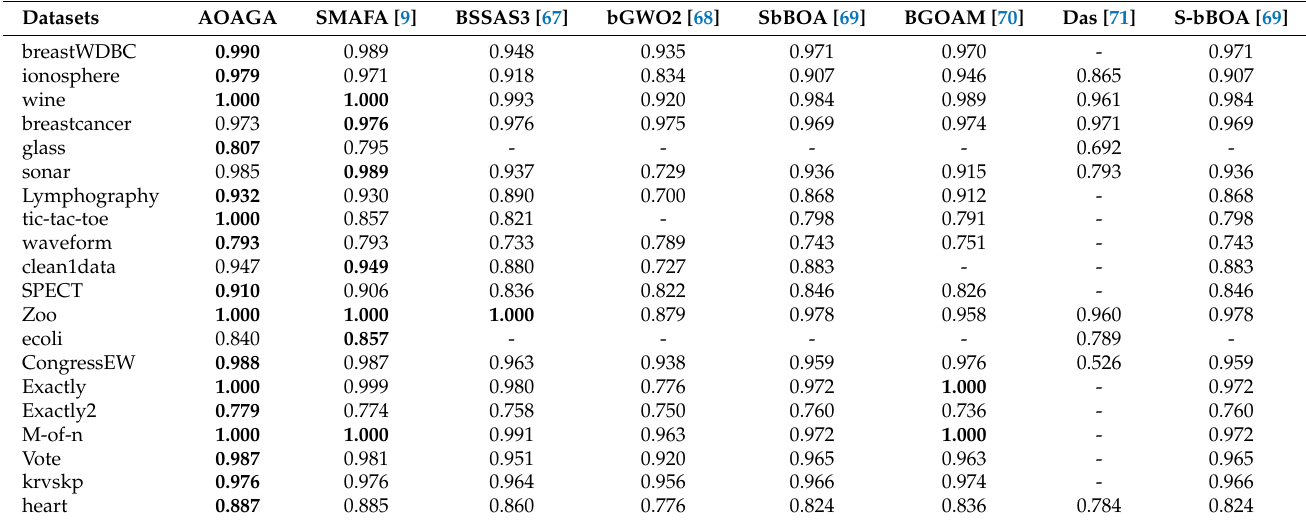
Table 10. Comparison with the state-of-the-art methods.